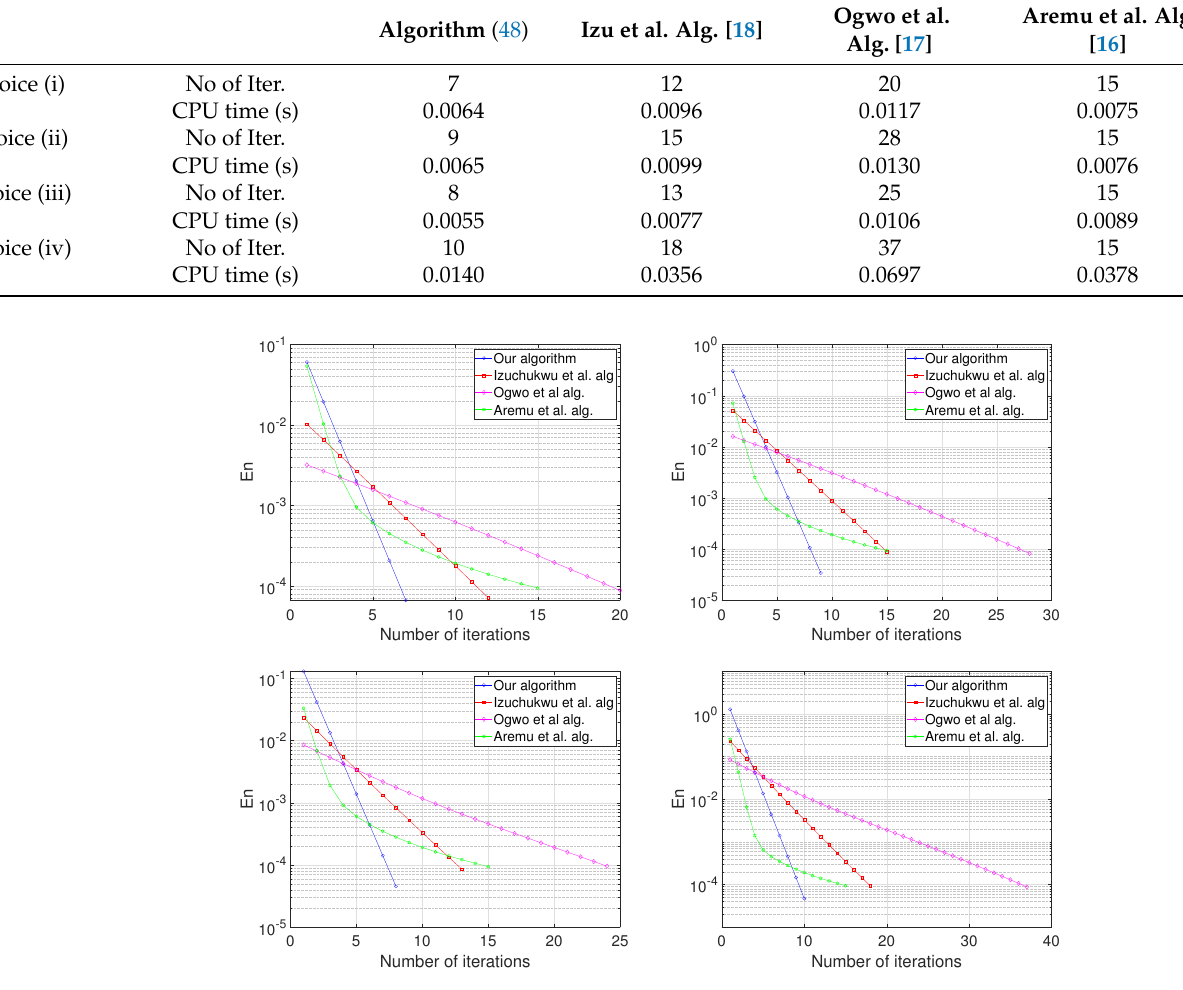
Figure 2. Example 1, ( Top Left ): Choice (i); ( Top Right ): Choice (ii); ( Bottom Left ): Choice (iii); ( Bottom Right ): Choice